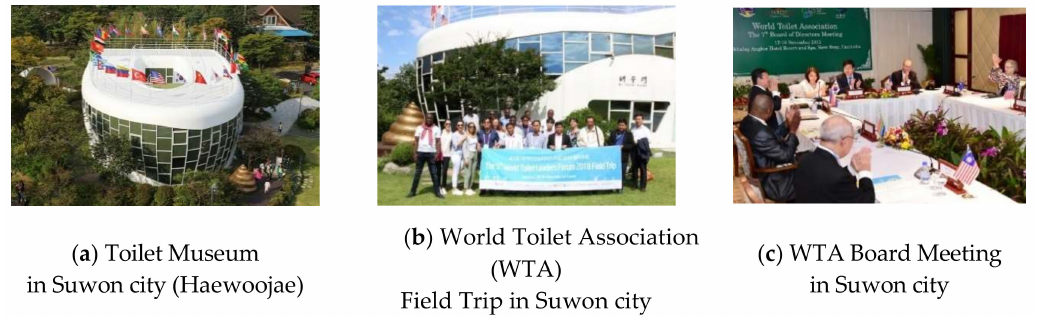
Figure 2. Birthplace of restroom culture, Suwon City. (Source Indication: ( a ) [SUWON CITY], [Visit Suwon (http: // suwon.go.kr / visitsuwon)]; ( b , c ) [Mr. Toilet House], [Mr. Toilet House, (https: // www.haewoojae.com /